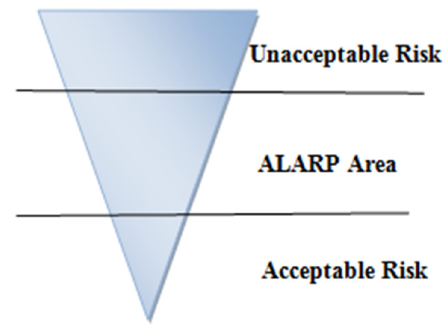
Figure 3. ALARP principle.